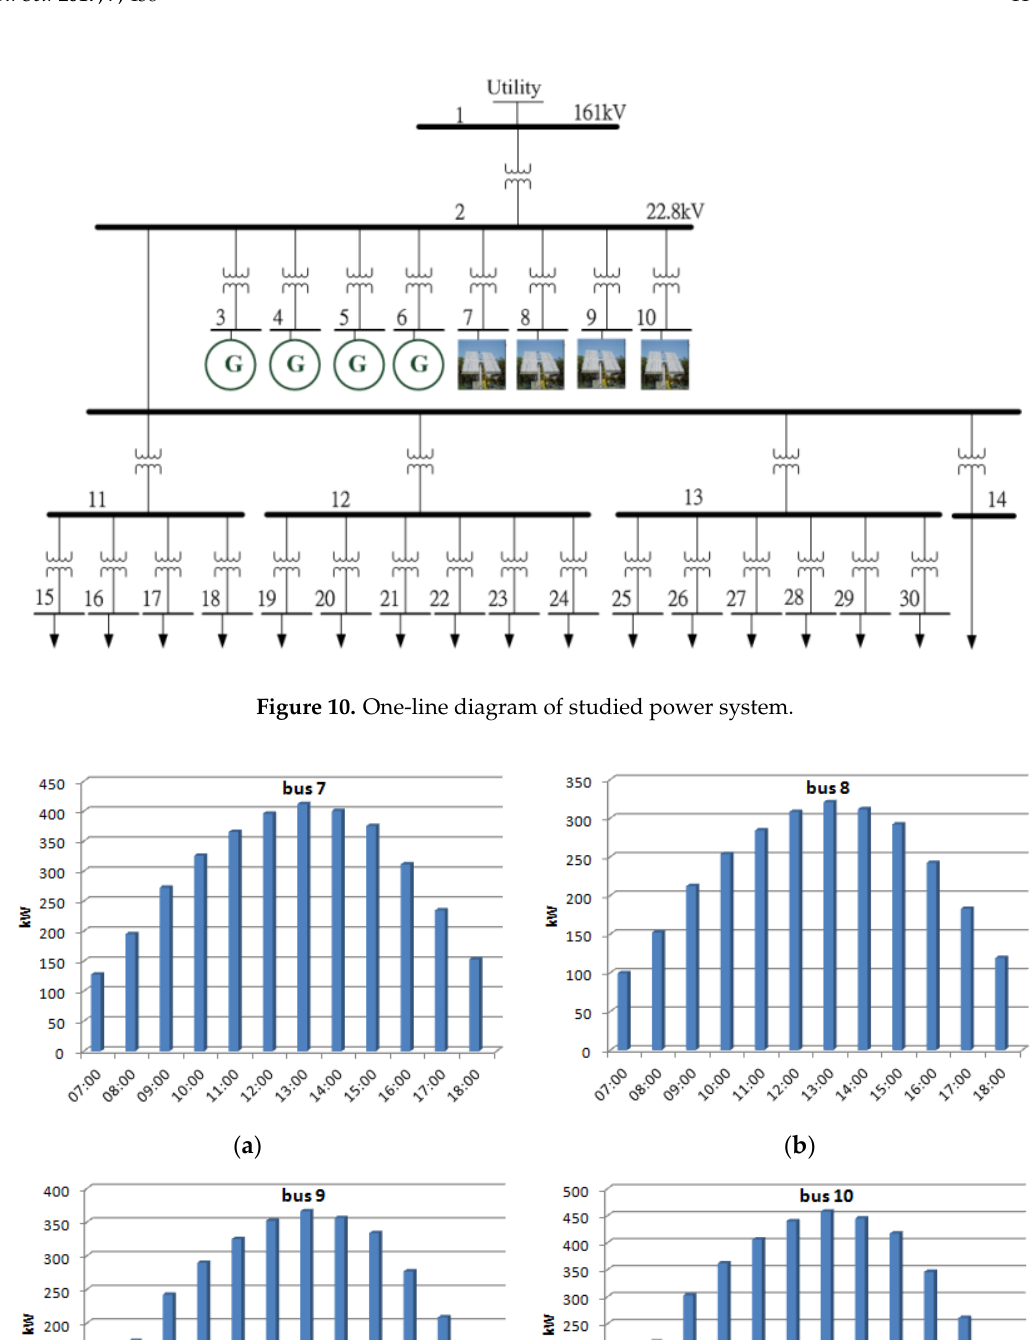
Table 2. Operational parameters of generators.